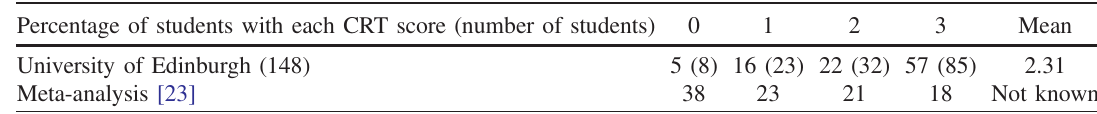
TABLE I. Percentage of students with each CRT score. Numbers in brackets give the number of students. Percentage of students with each CRT score (number of students)